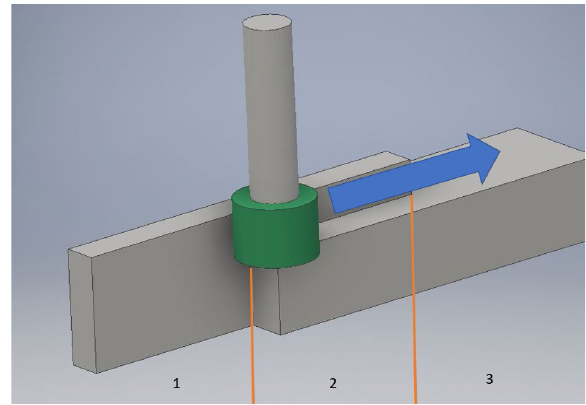
Fig. 3. Sample geometry and tool kinematic . The samples used are 20x20x100 mm 3 in size. The tool will move in a straight line, processing 3 different areas. The first area will be lateral grinding only (1), the second area will be a combination of face and lateral grinding (2) and the third area will be face grinding only (3) as marked in Fig. 3. Due to the geometry of the sample as well as the tool, the cutting speed will have the same value for face grinding as well as lateral